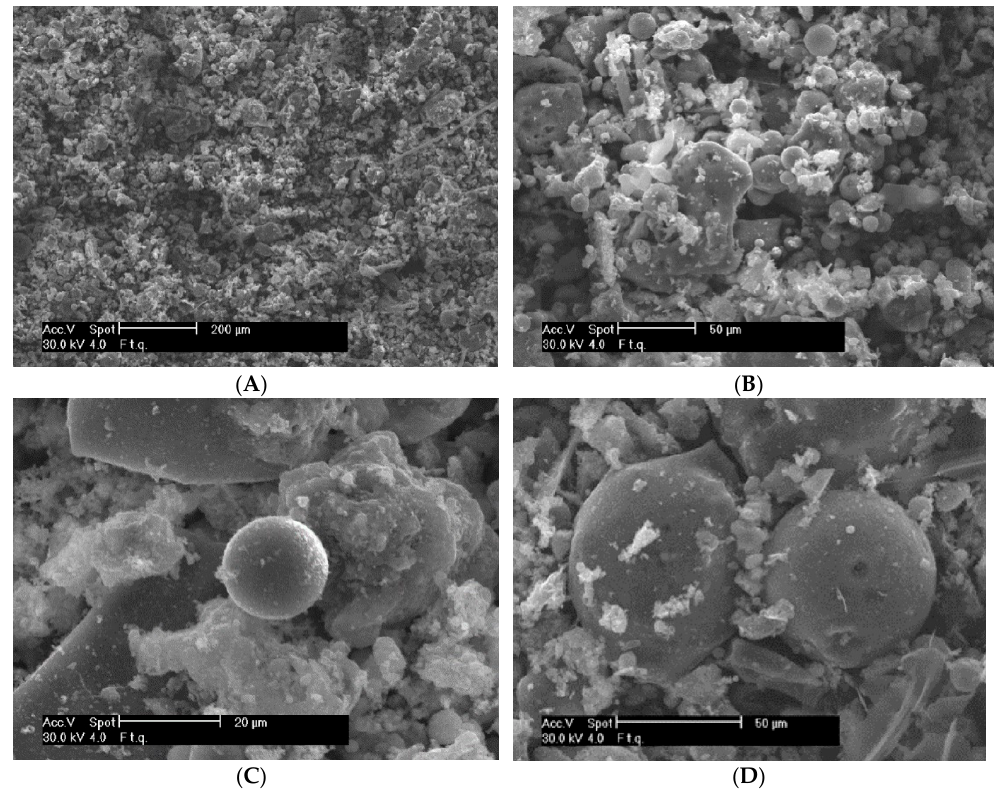
Figure 3. Scanning electron micrograph of WCSA particles. ( A ) Overview of WCSA sample, different zoom areas of the WCSA: ( B ) unburnt particles, ( C , D ) fly ash